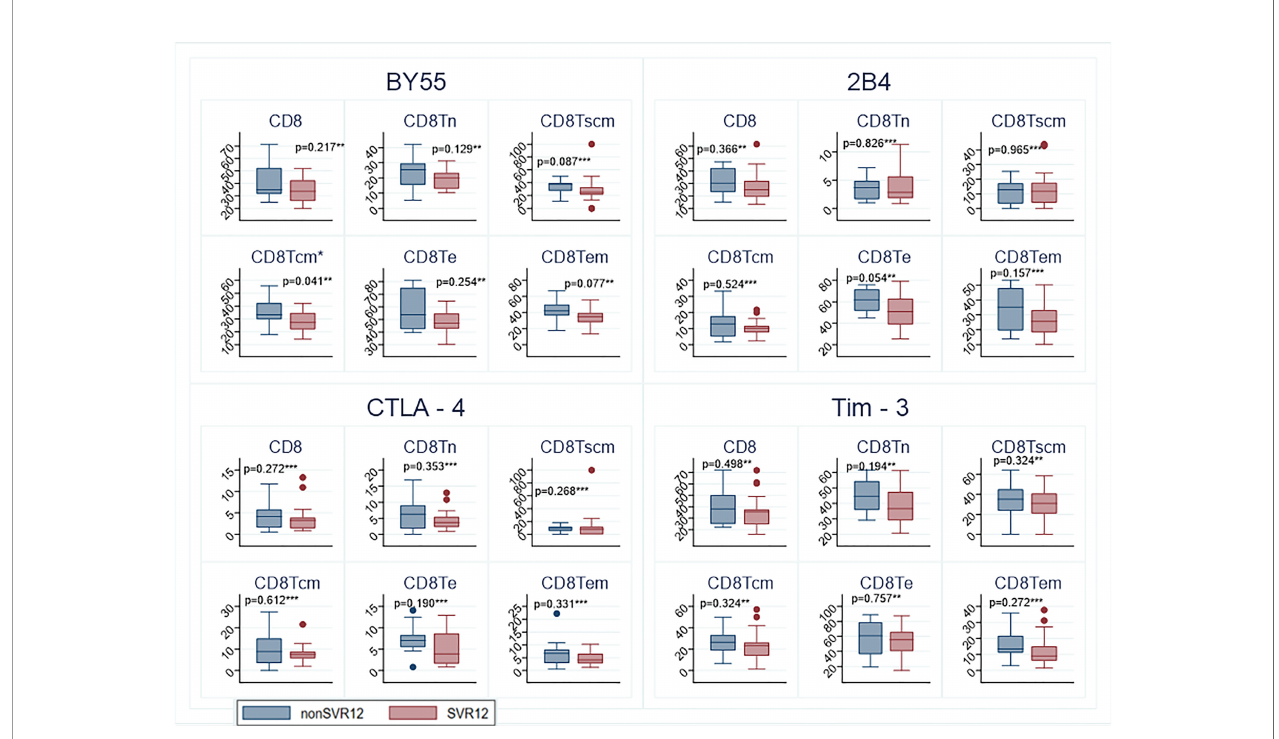
FIGURE 2 | Expression of the inhibitory receptors BY55, 2B4, CTLA-4 and Tim-3 on CD8+ T cells at baseline from patients who achieved cure and patients with treatment failure. The colored dots represent measurements outside the IQR range. sustained virological response (SVR); naïve T cells (Tn); stem cell memory T-cells (Tscm); T central memory cell (Tcm); terminal effector T-cells (Te); T effector memory cell (Tem). Signi fi cant values marked with *. Statistical analyzes according to test for signi fi cance ** t test *** Wilcoxon Mann-Whitney